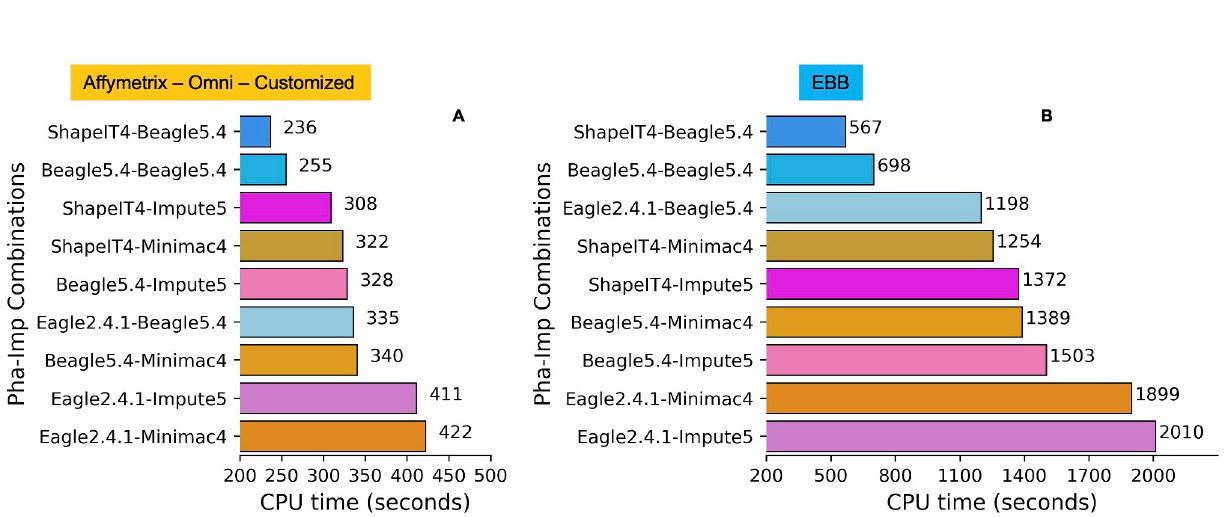
Fig 15. CPU run time and memory usage of imputation software for EBB chip data. Average run time for imputation (A) tools. Average memory usage for imputation (B) tools in EBB chip data.